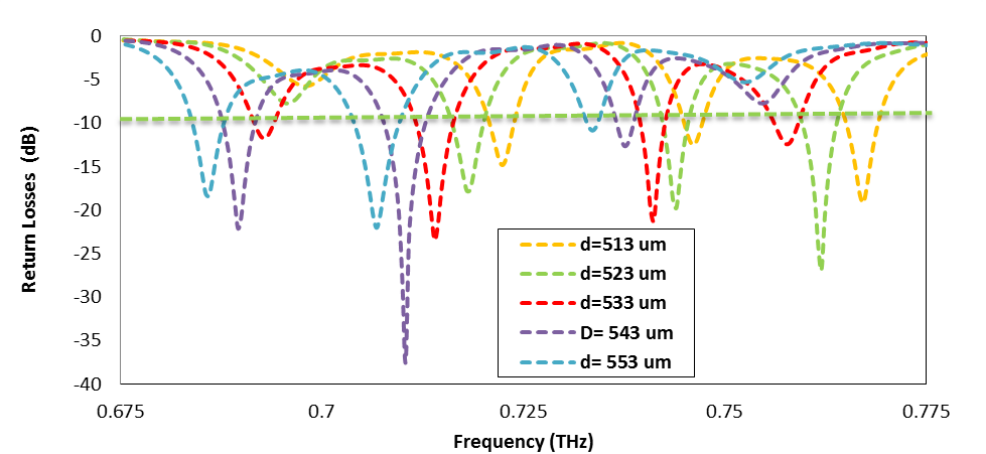
Figure 9. Parametric analysis of Type C antenna array.